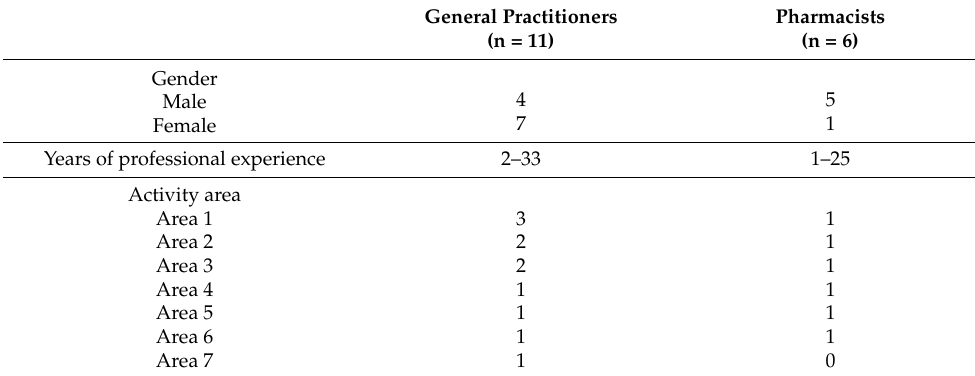
Table 2. Participants’